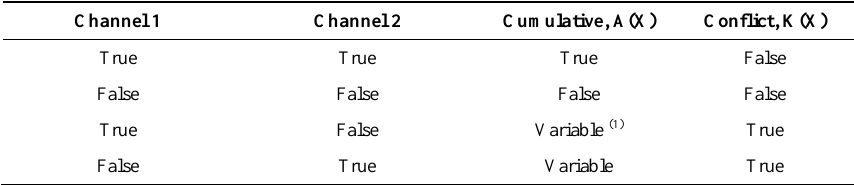
Table 1. Cumulative and conflict decision